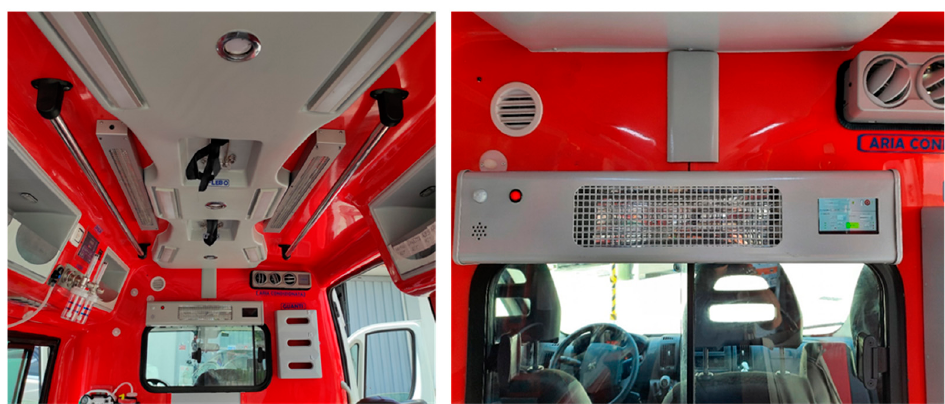
Figure 1. UV-SAN System Architecture.